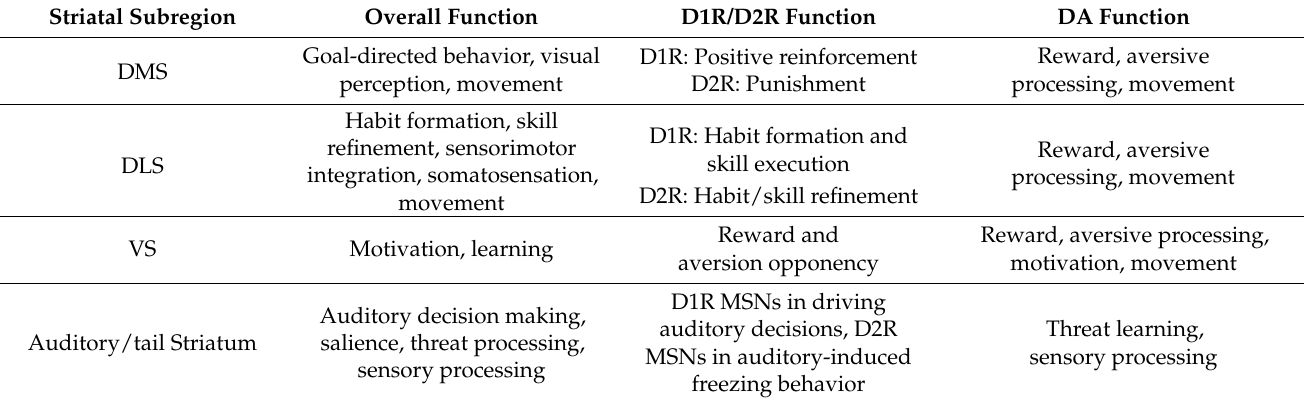
Table 1. Highlighted summary of details characterizing each striatal